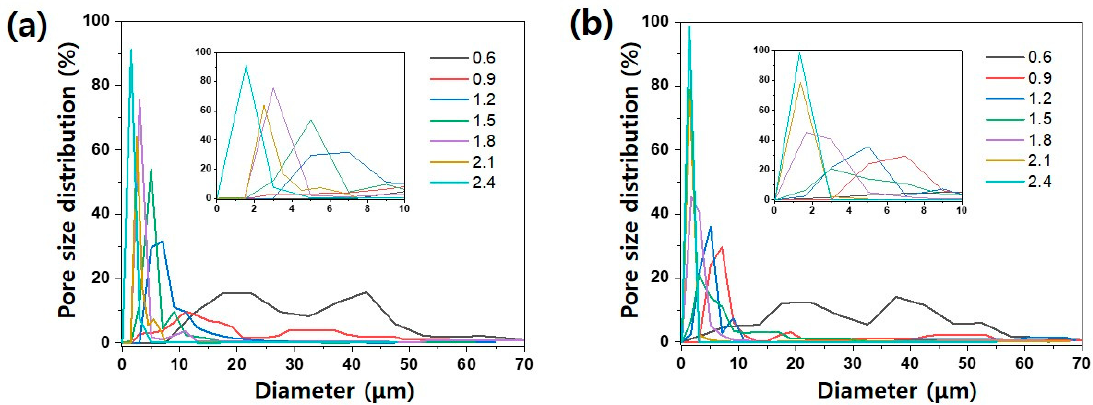
Figure 4. Pore-size distribution of ( a ) PAN and ( b ) PAN–CTAB filter media with varying base weight of the electrospun web.